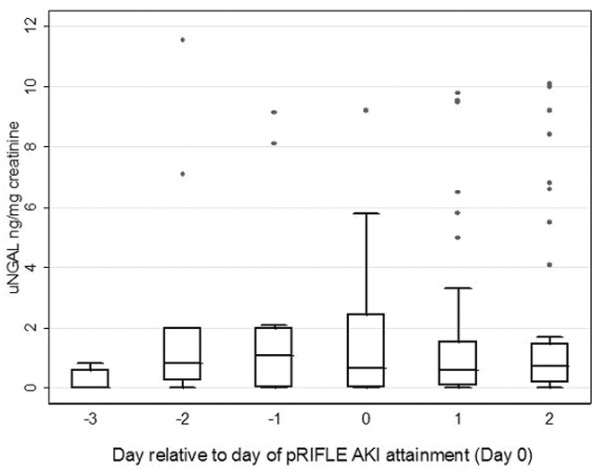
uNGAL concentrations from 3 days before to 2 days after sustaining AKI. The center lines represent the median values and the two outer lines represent the interquartile range. AKI, acute kidney injury; pRIFLE, pediatric modified Risk, Injury, Failure, Loss, End Stage Kidney Disease; uNGAL, urine neutrophil gelatinase-associated lipocalin.